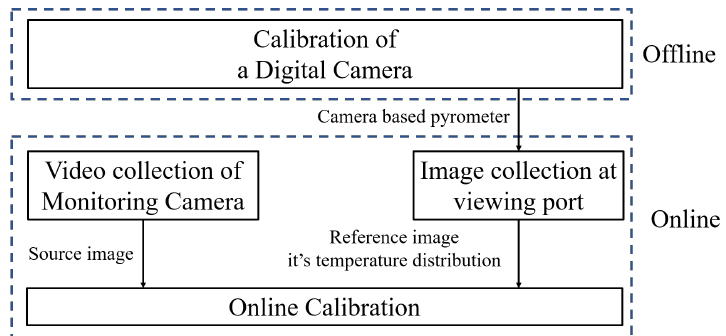
Figure 1. Procedure of online